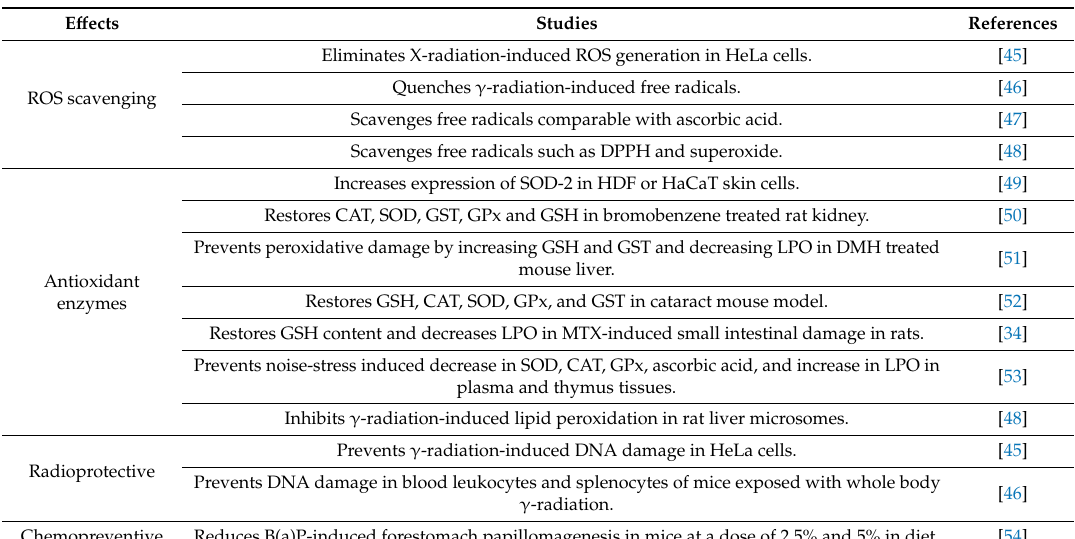
Table 1. Antioxidant and chemotherapeutic e ff ect of